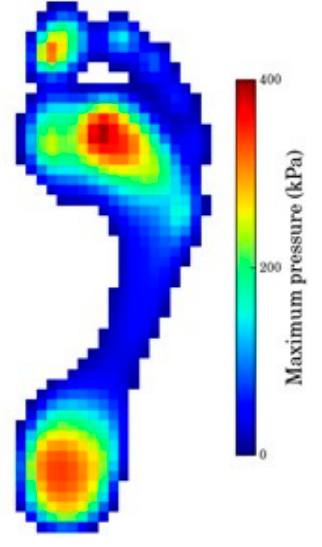
Figure 1. Typical plantar pressure distribution (licensed under the Creative Commons Attribution- Share Alike 3.0).